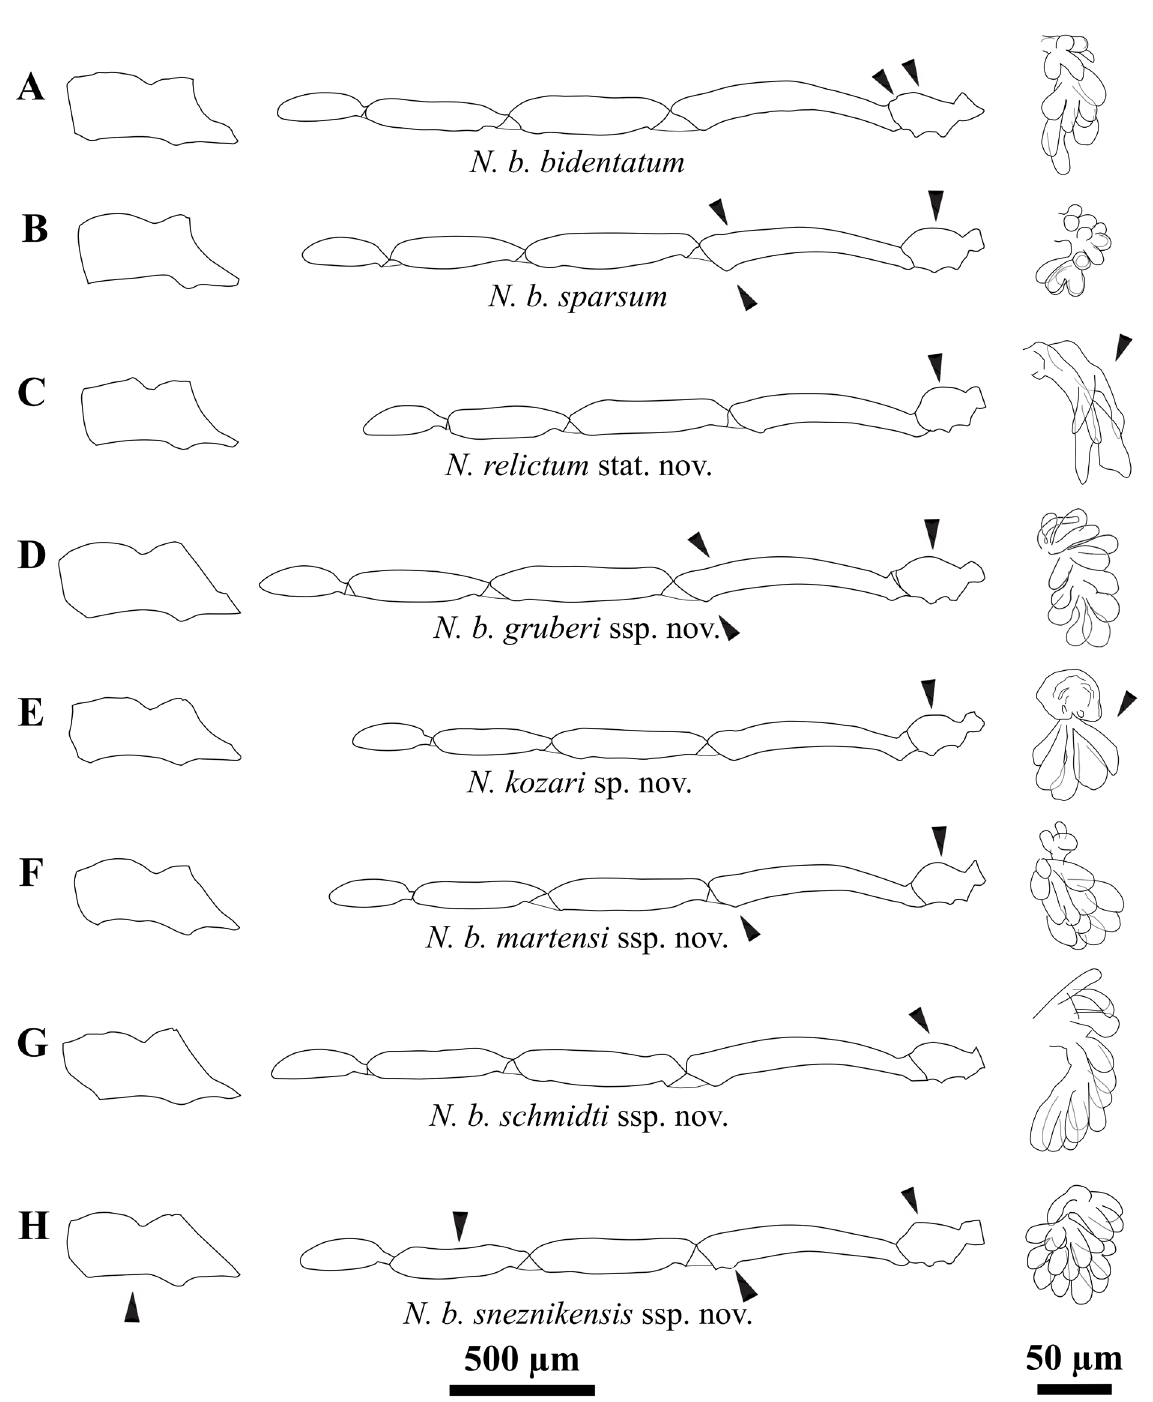
Fig. 13. Nemastoma bidentatum Roewer, 1914 complex, ♀♀. From left to right: Silhouettes of the Ch basal article, Pa (both medial view) and Rec sem. Arrows indicate the most identifying characters. Note: female N. pluridentatum (Hadži, 1973) stat. nov. is